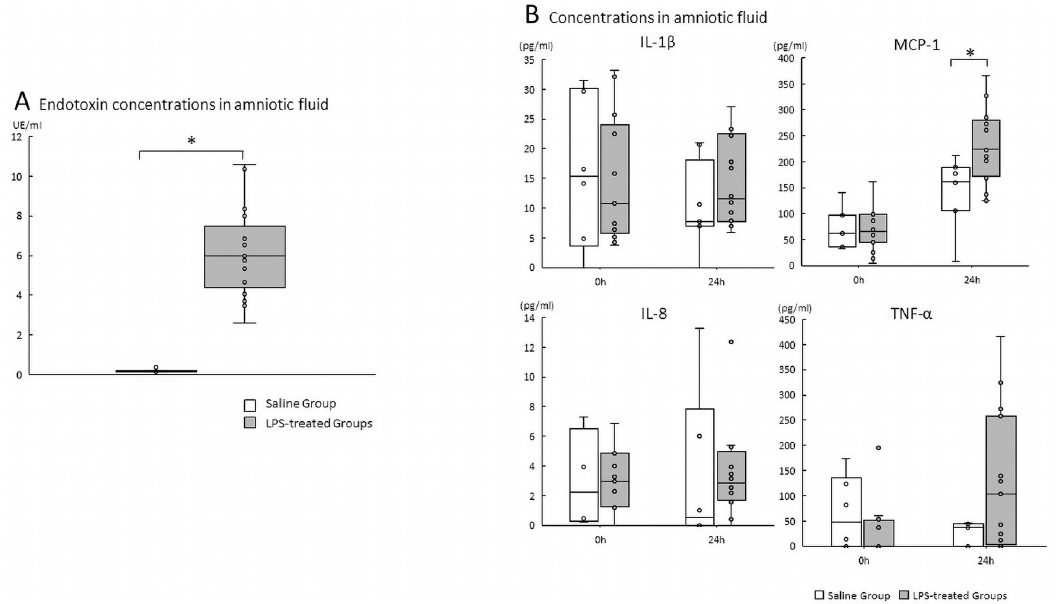
Fig 2. A. Endotoxin concentrations in amniotic fluid. Plots show median, 25th, and 75th percentile ranges of AF endotoxin concentrations at 24 hours post-administration as boxes and 5th to 95th percentile as error bars. � p < .05 vs. the Saline Group. n = 6–10 animals/group. AF, amniotic fluid; LPS, lipopolysaccharide. B. Cytokines/chemokine concentrations in amniotic fluid from 0 to 24 hours after either saline or LPS. A, amniotic fluid IL-1 β , IL-8, MCP-1, and TNF- α concentrations. � p < .05 between the Saline Group and the LPS-treated Groups (LPS Group and LPS + rytvela Group). Plots show median, 25th, and 75th percentile ranges as boxes and 5th to 95th percentile as error bars. n = 4–8 animals/group. AF, amniotic fluid; LPS, lipopolysaccharide; ELISA, Enzyme-linked inmmunosorbent